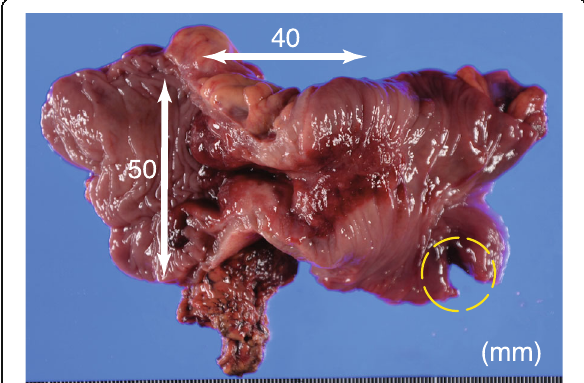
Fig. 3 Colectomy specimen. Gross examination of the specimen revealed a large central tumor and a small perforated hole (dotted circle) adjacent to the tumor. Histopathology identified moderately differentiated adenocarcinoma of the colon (S, Type 2, 50 × 40 (mm), pT4b, int, INF- β , ly1, v2 (EMG), PN1b, pNx, pPM0 (15 mm), pDM0 (40 mm), RM1), categorized as stage IV, according to both the Japanese and TNM classifications